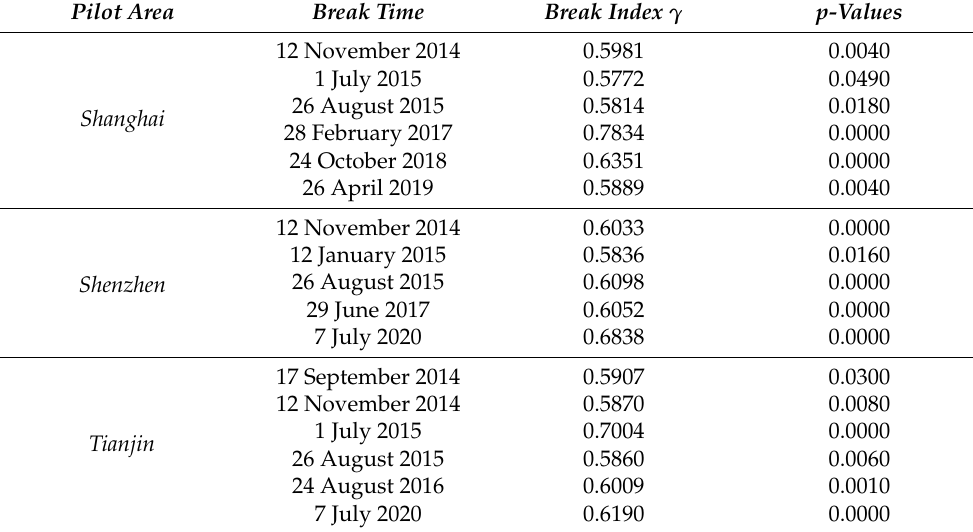
Table 2. Breakpoint test results of carbon price in several pilot markets in China. Pilot